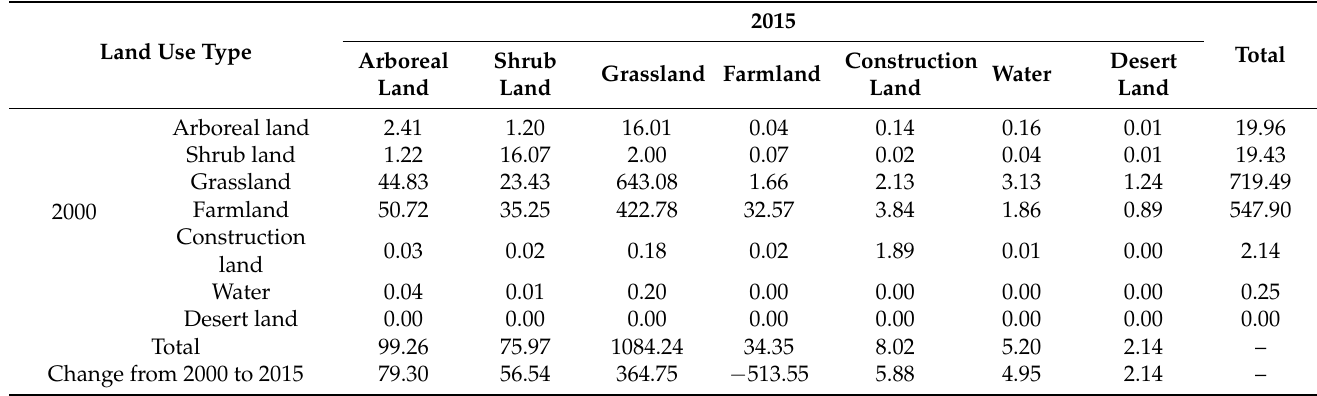
Table 3. Transfer matrix of land use changes in the Ansai Watershed from 2000 to 2015 (km 2 ).